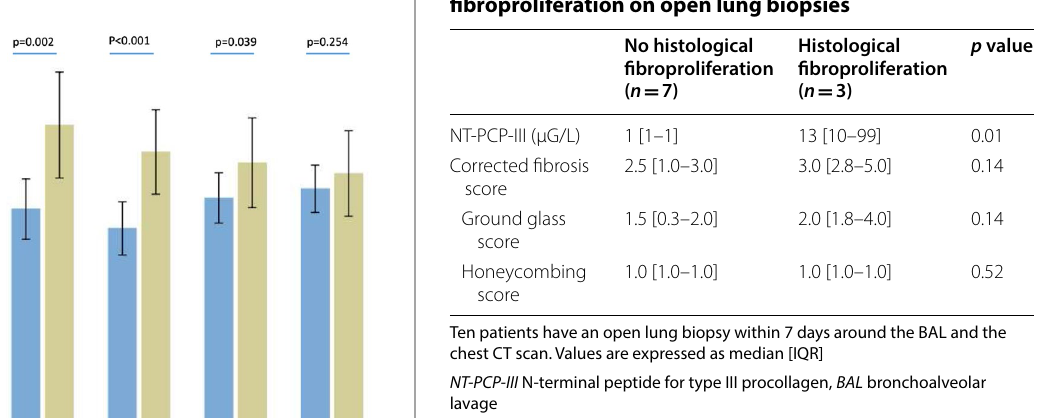
Table 4 Relationship between the level of alveolar NT-PCP-III, CT scan fibrosis score and the histological